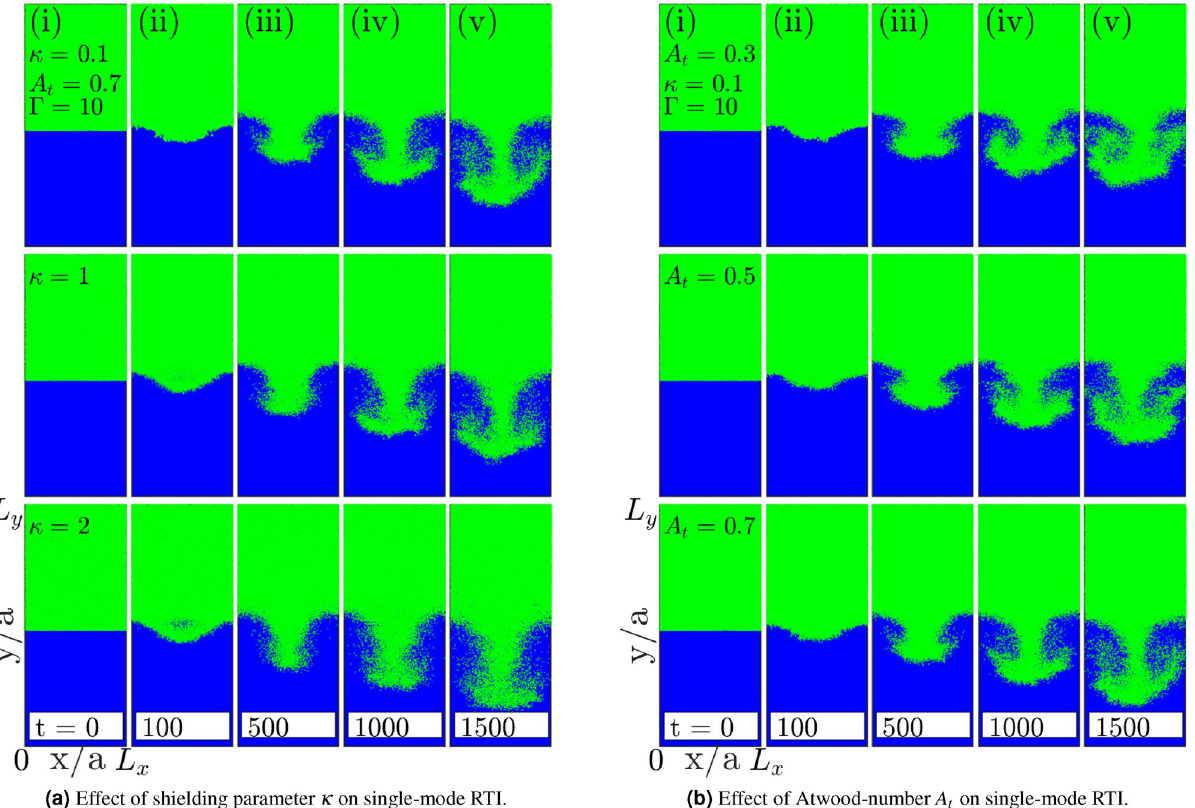
1 pl s) κ = 0.1, 1 and